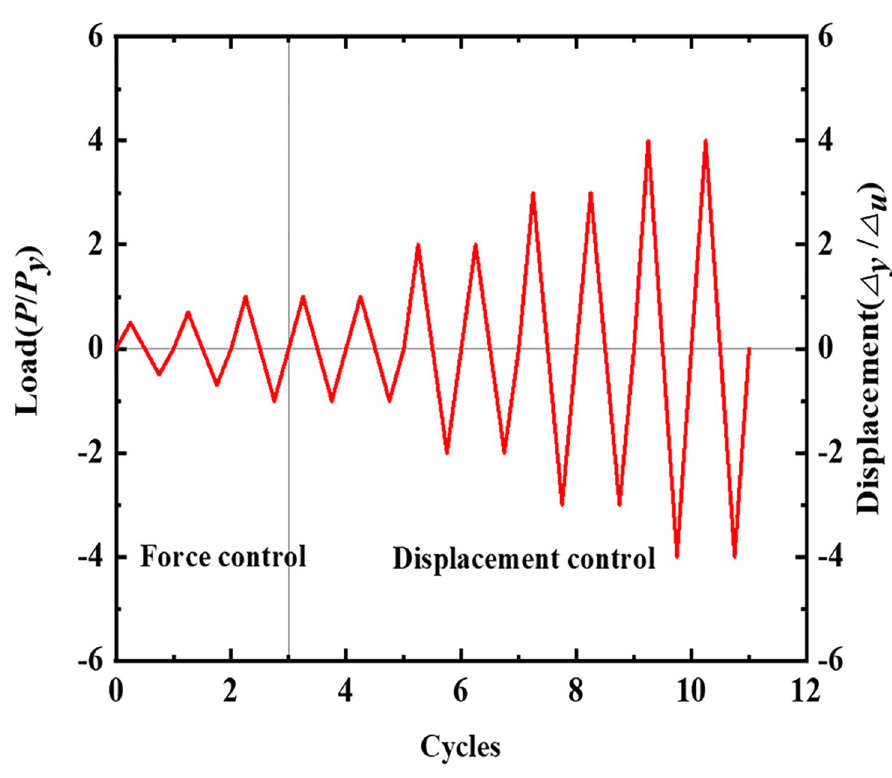
Fig 9. Loading sequence.